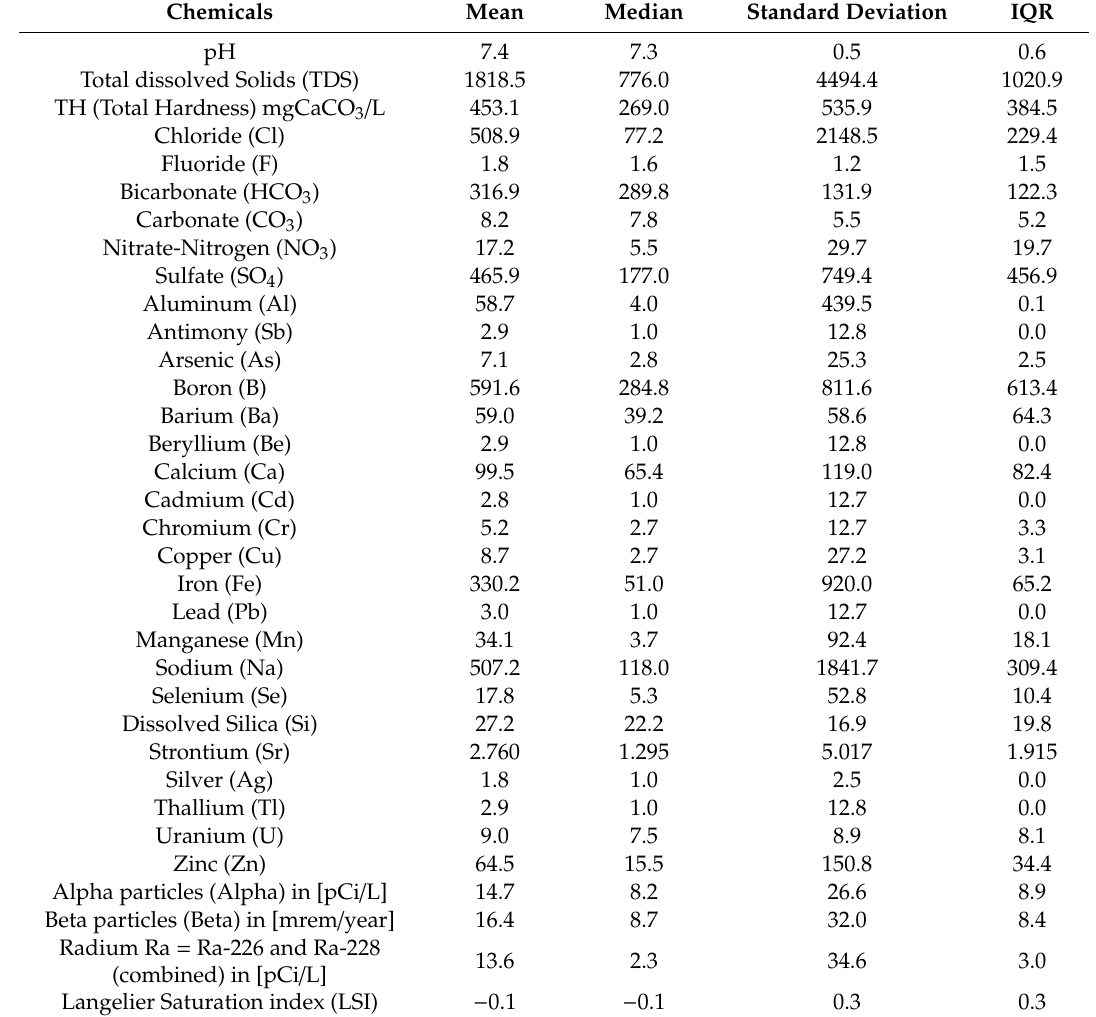
Table 1. Summary statistics of water quality parameters in the Dockum Hydrostratigraphic Unit (HSU) (all the values are in mg / L, unless noted otherwise; IQR is Inter Quartile